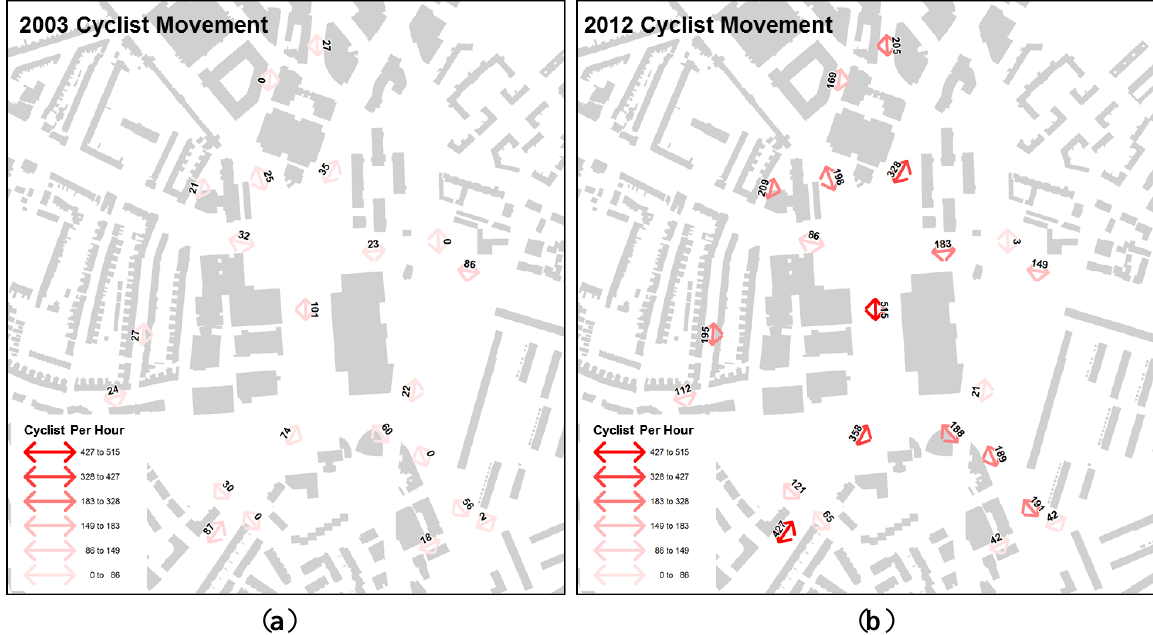
© Crown Copyright/database right 2014. An Ordnance Survey/EDINA supplied service. Figure 8. ( a ) Average all-day hourly cyclist movement pattern for the case study area in 2003 ( left) ; ( b ) Average all-day hourly cyclist movement pattern for the case study area in 2012 ( right